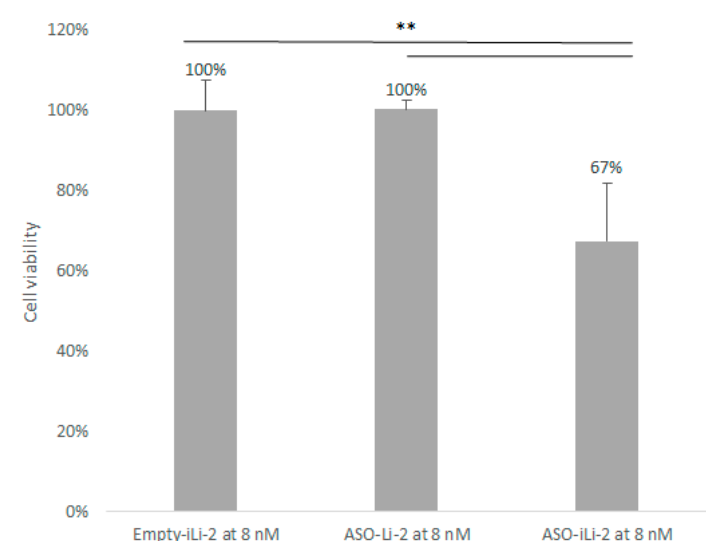
Figure 10. Cell viability (%) of 5000 PC-3 cell spheroids when exposed to Empty-iLi-2 at 8 nM, ASO-Li-2 at 8 nM and ASO-iLi-2 at 8 nM (***, 0; **, 0.001; * 0.01). Cell viability results obtained were confirmed by microscopic observation (Figure 11). Observations were made on days 1 (24 h after cell seeding), 8 and 15.